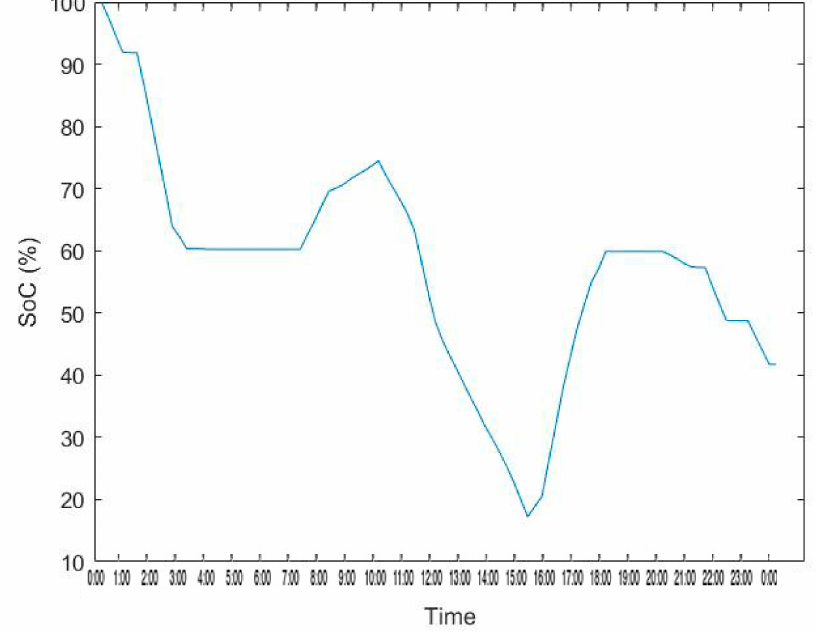
Figure 23. State of charge of Street Battery in